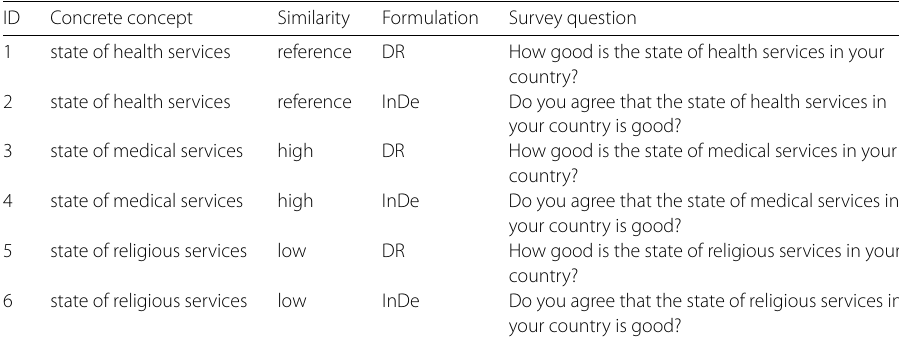
Table 2 Example Questions from Our Survey Question Data Set. InDe: interrogative-declarative request. DR: direct